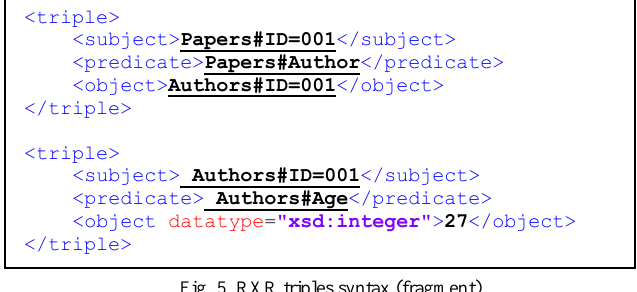
Fig. 5. RXR triples syntax (fragment).